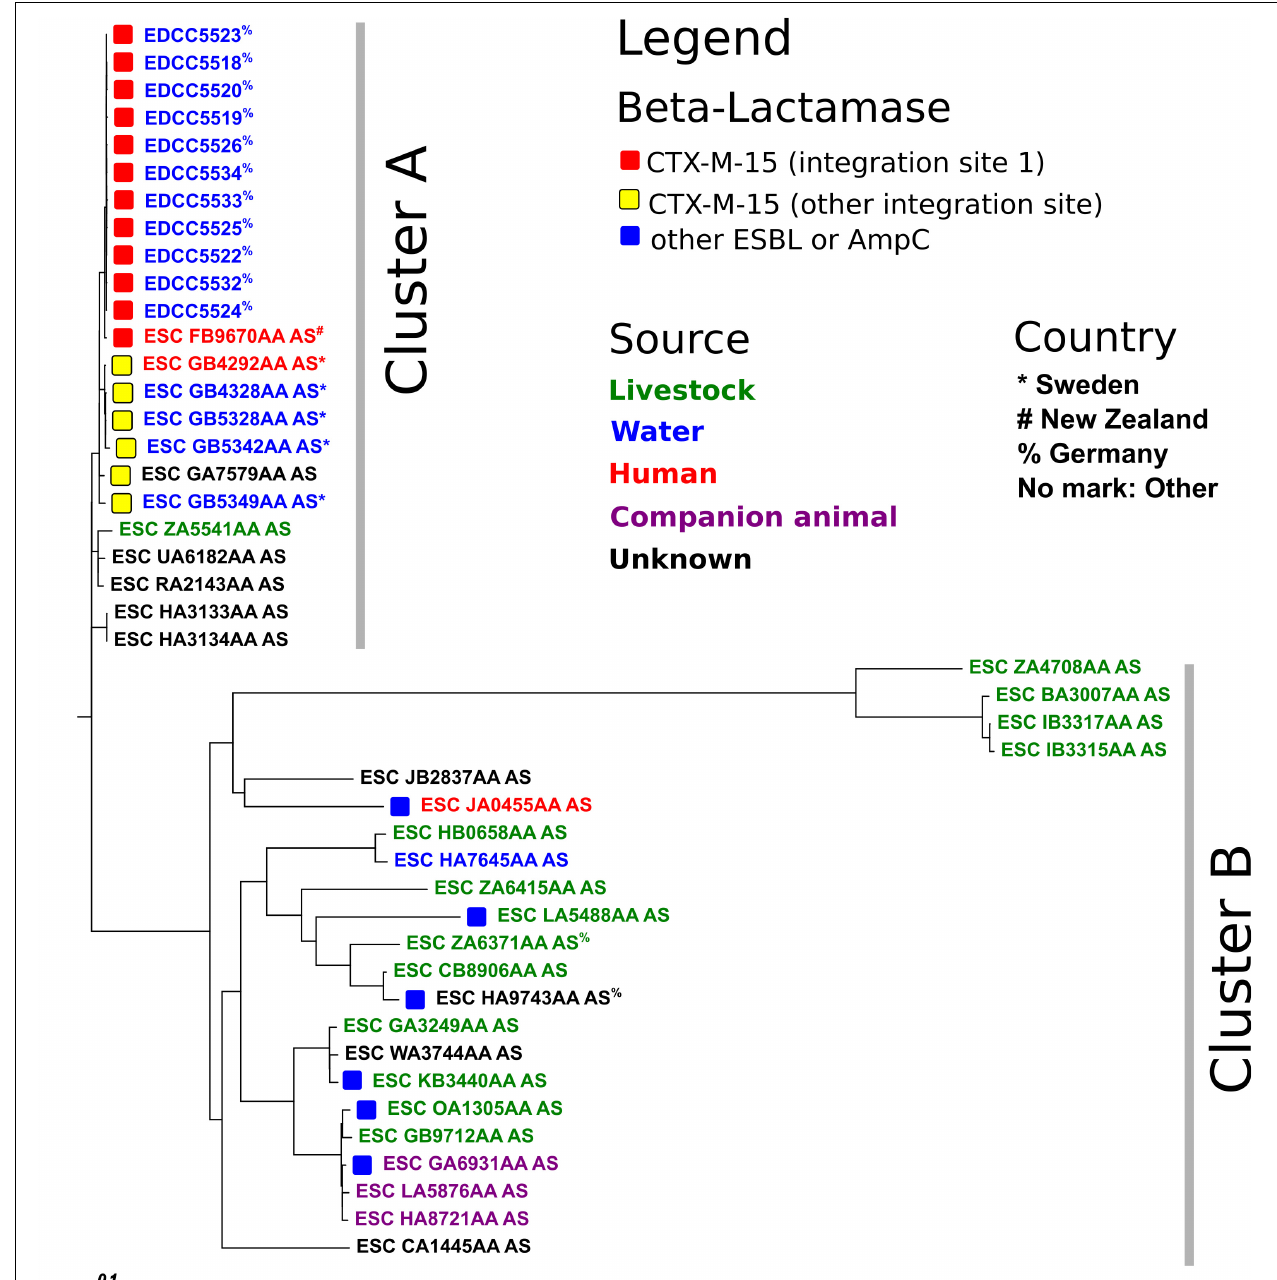
FIGURE 3 | Core-genome-based phylogenetic tree of E. coli ST-949 isolates from this study and Enterobase (as of 8th June 2020). For a representation of the isolate sampling site, please see Supplementary Figure 1